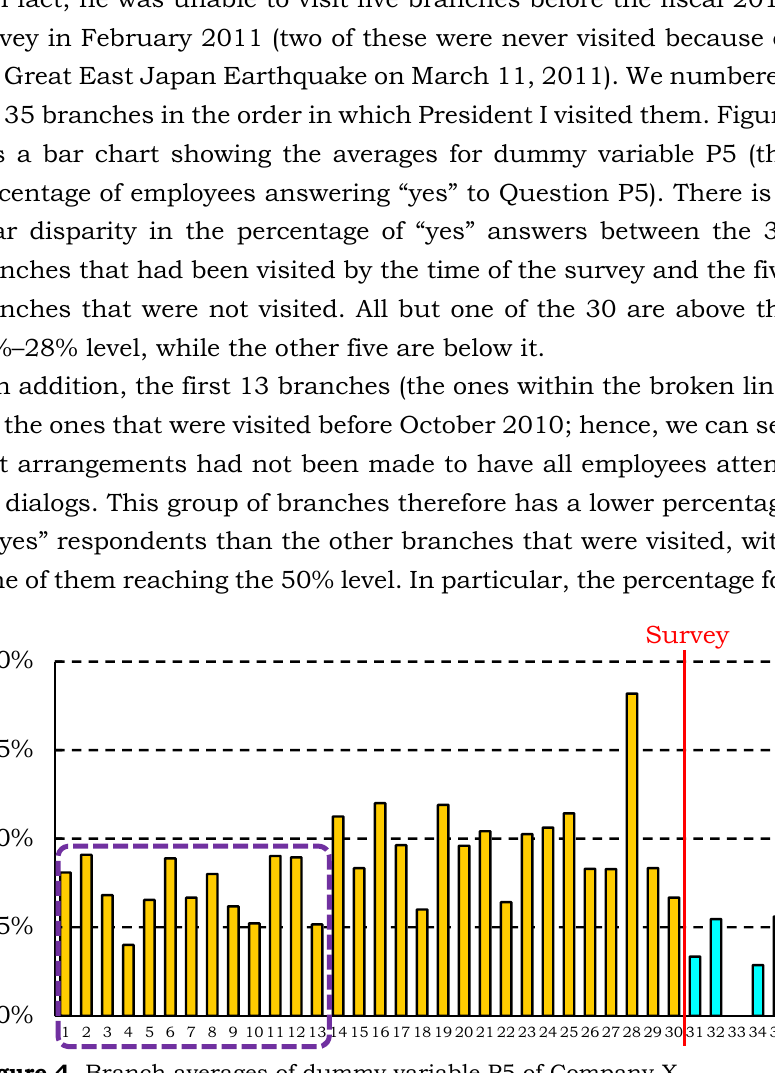
Figure 4. Branch averages of dummy variable P5 of Company X Source: Takahashi (2011) Figure